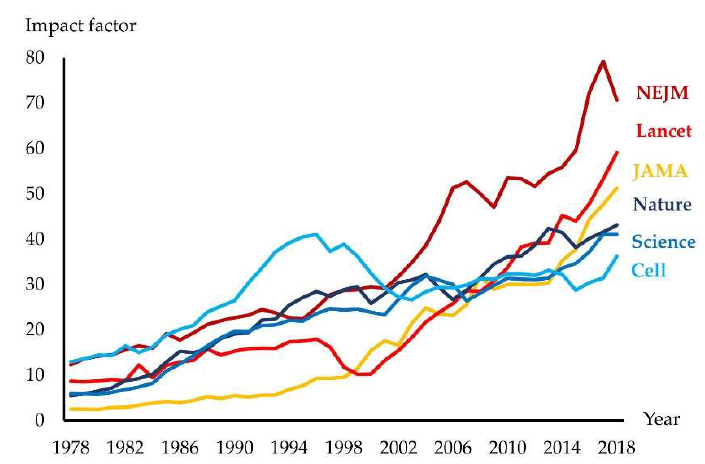
Figure 1. The impact factor for leading international journals. JAMA: Journal of the American Medical Association; NEJM: The New England Journal of Medicine